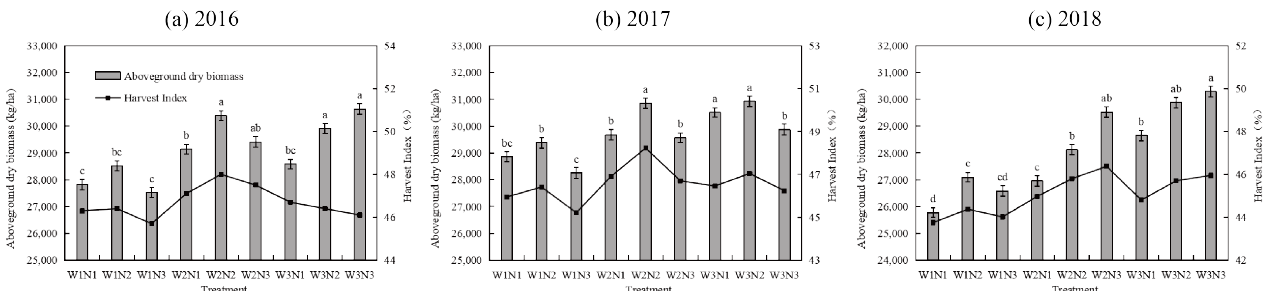
Figure 4. Dry weight of above-ground biomass and harvest index of corn after harvest. ( a ) 2016. ( b ) 2017. ( c ) 2018. Statistical comparisons were made by one-way ANOVA. Different characters mean significant differences found at p <